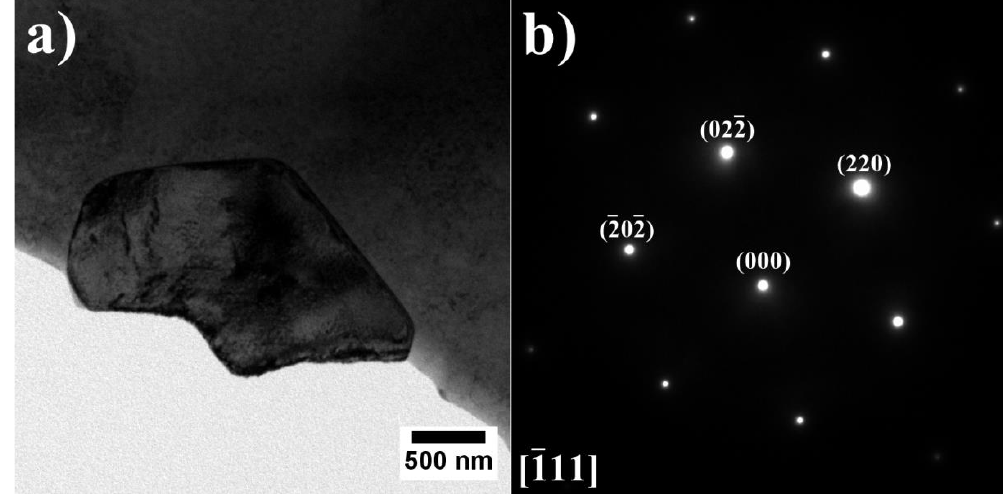
Figure 13. ( a ) morphology of the TiN; ( b ) corresponding SAED pattern, TEM-BF. Sobczak et al. [43], during a systematic study on the HAYNES ® 282 superalloy’s casta- bility, carried out casting trials under non-vacuum conditions, similar to our investigation. The superalloy, which melted without deoxidizing, contained 0.38 wt% of oxygen and 0.02 wt% of nitrogen. To decrease the oxygen content, the molten superalloy